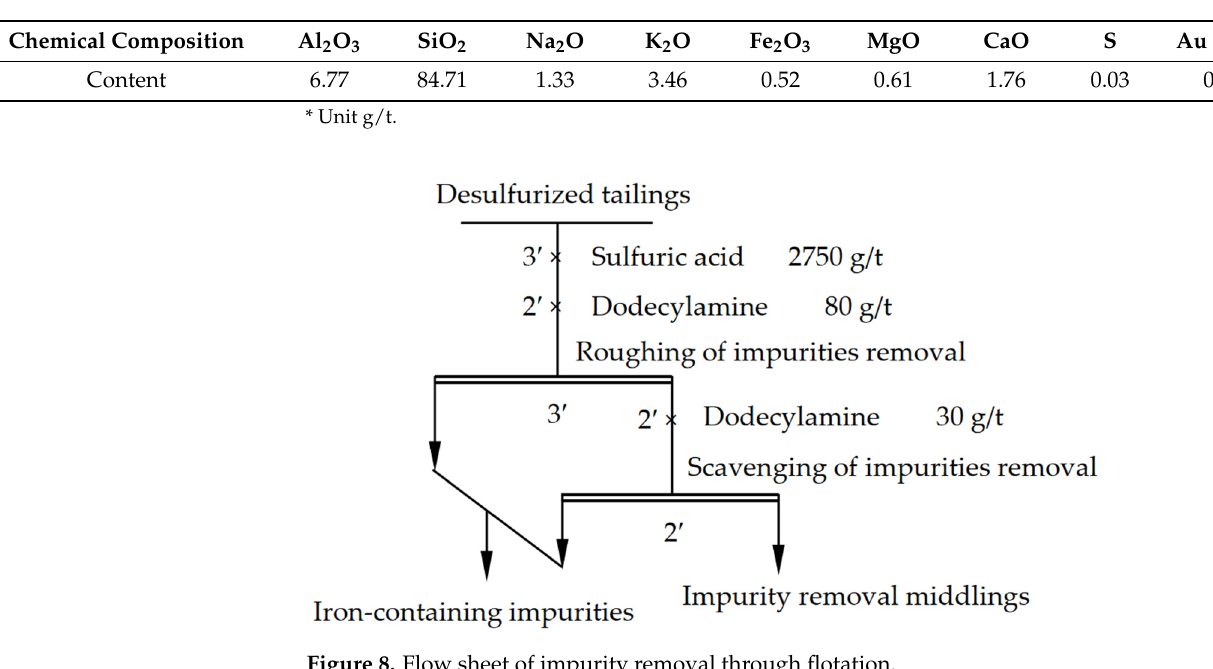
Table 8. Chemical composition of desulfurized tailings (mass fraction, %).